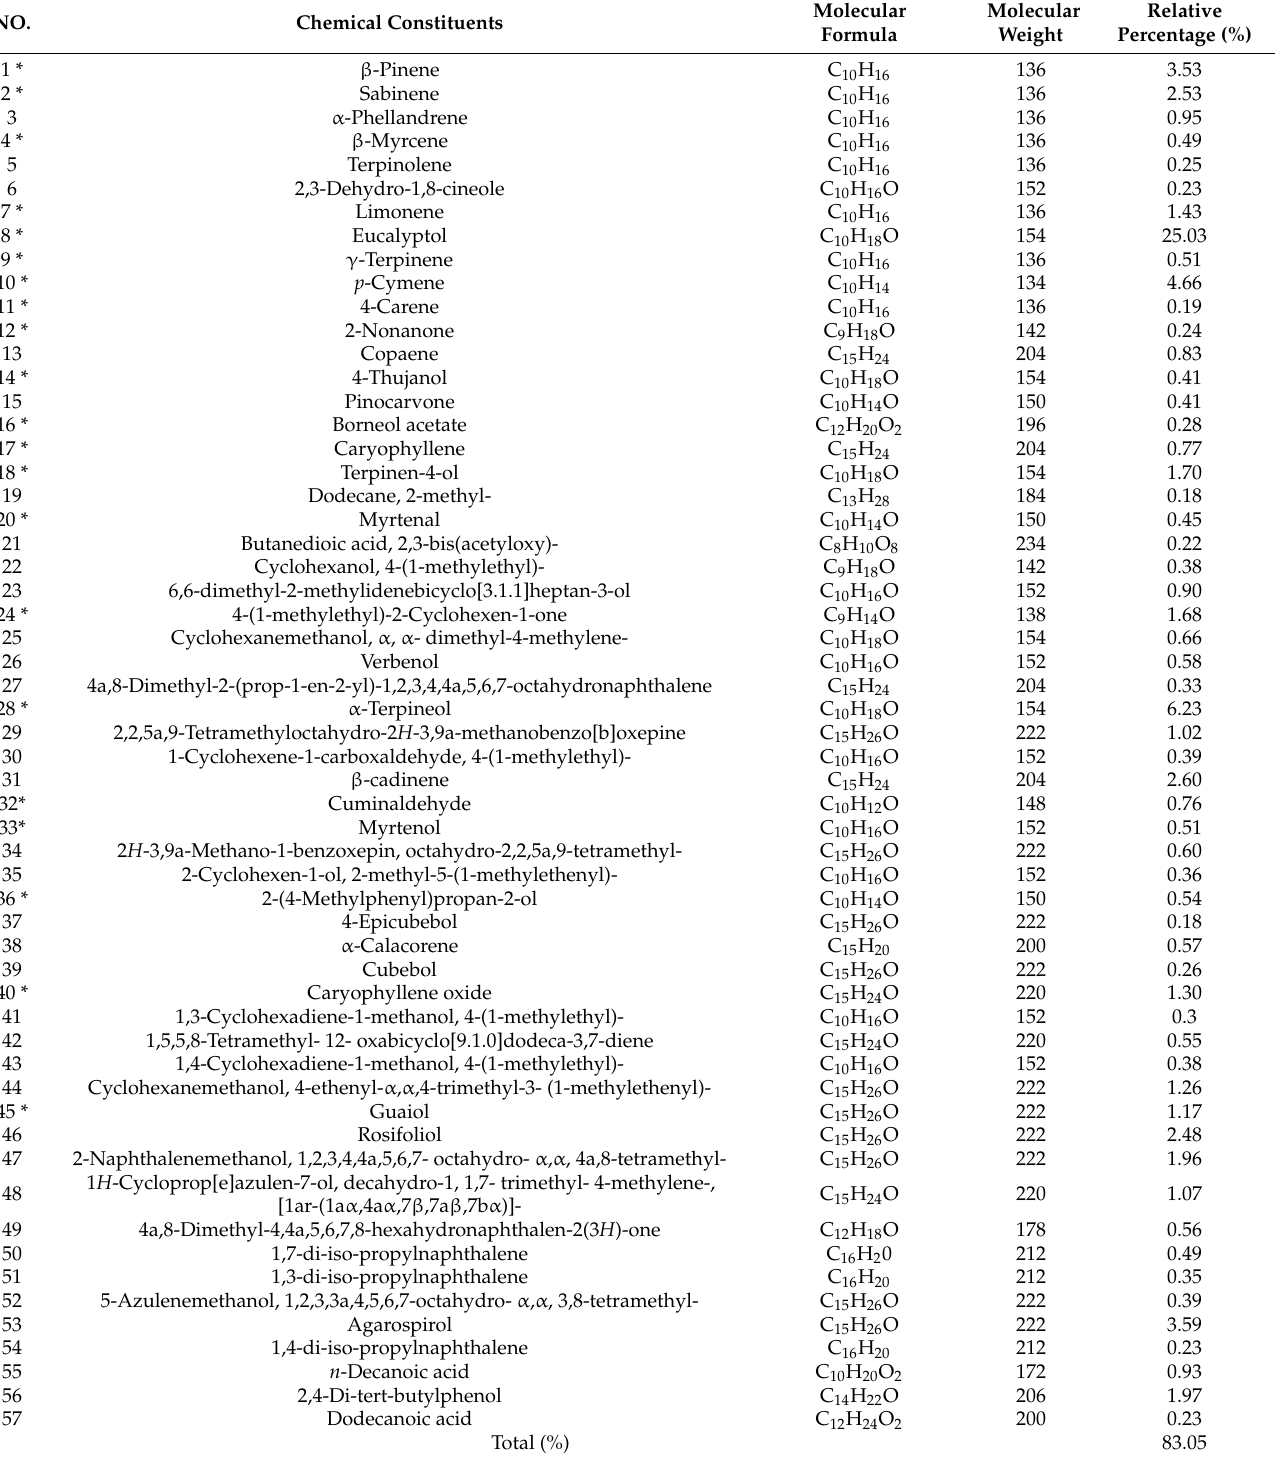
Table 1. Chemical constituents of Oleum Cinnamomi